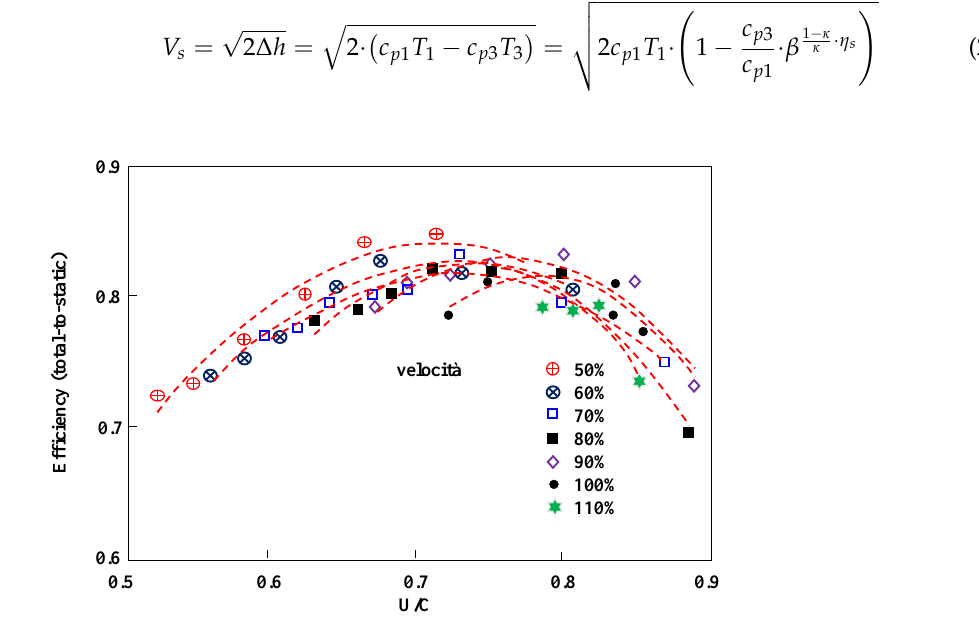
Figure 7. Baines chart.